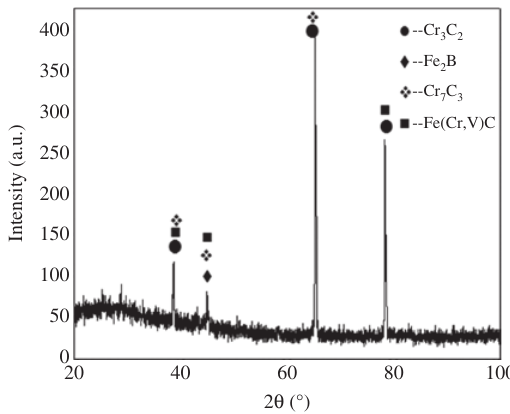
Figure 6 The XRD pattern for FeCrBVC alloy